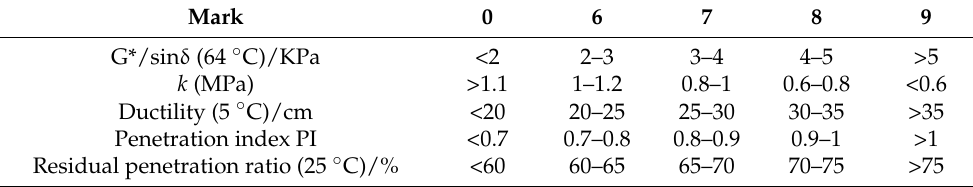
Table 8. Determination of adjacent grade scores.